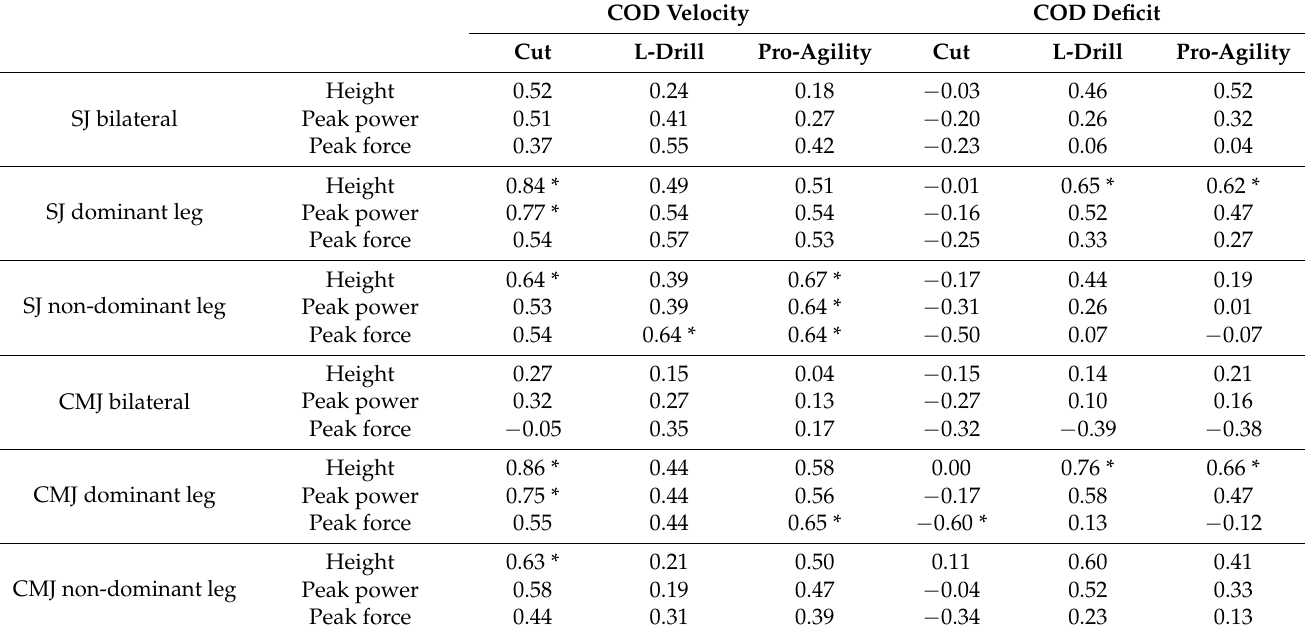
Table 5. Correlation coefficients between change of direction velocity and deficit in the three different protocols performed and unilateral and bilateral vertical jumps.